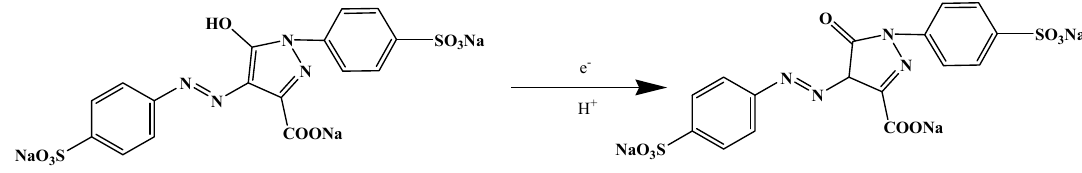
Scheme 1. The proposed reaction of tartrazine detection using electrochemical technique. The oxidation occurs at 1.1 V under optimized condition.